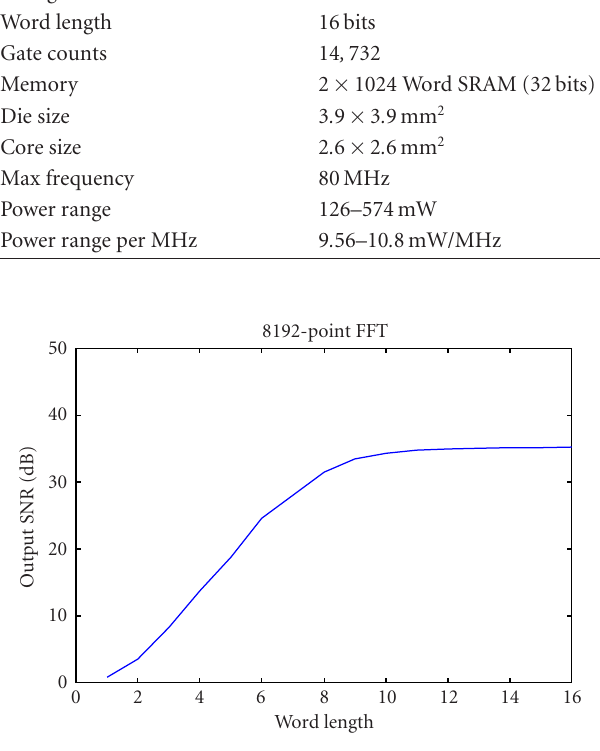
Figure 12: Fixed-point simulation of coe ffi cient word length.